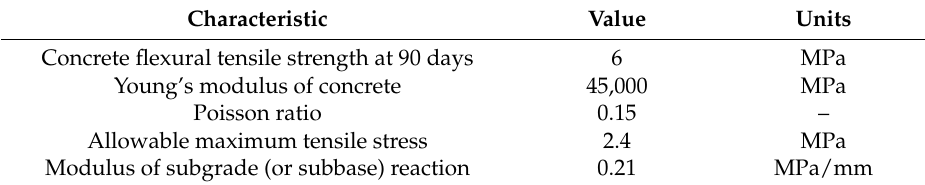
Table 7. Mechanical and physical characteristics of pavement